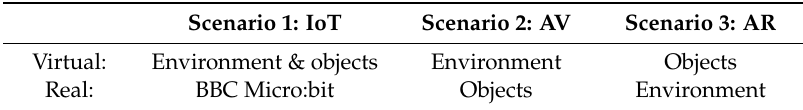
Table 1. Blending of virtual and real in the three curiosity cabinet implementations. AR—augmented reality; IoT—internet of things; AV—augmented virtuality.